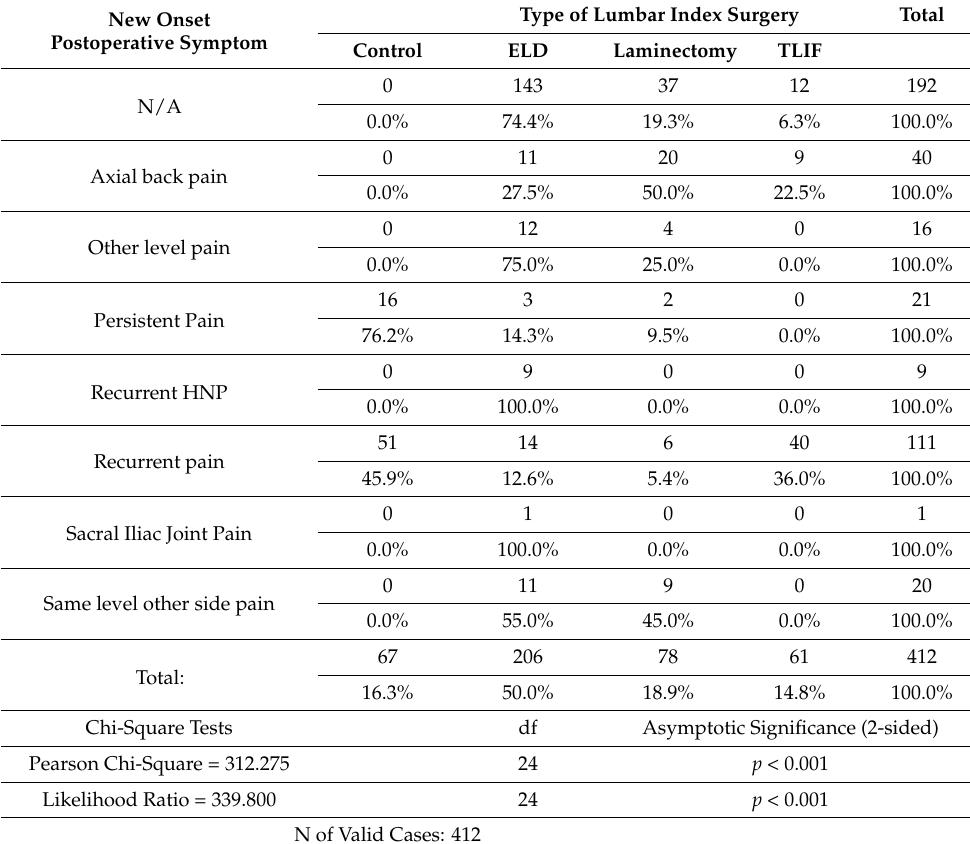
Table 4. New onset postoperative symptoms prompting new treatments after the index